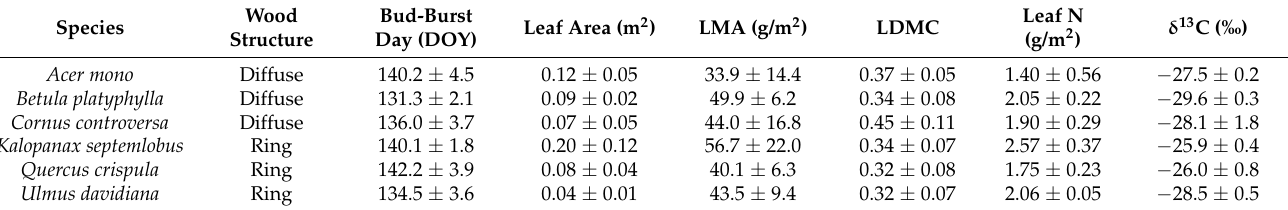
Table 1. The average value ( ± SD) of the functional traits of six species tested in our study. Wood Species